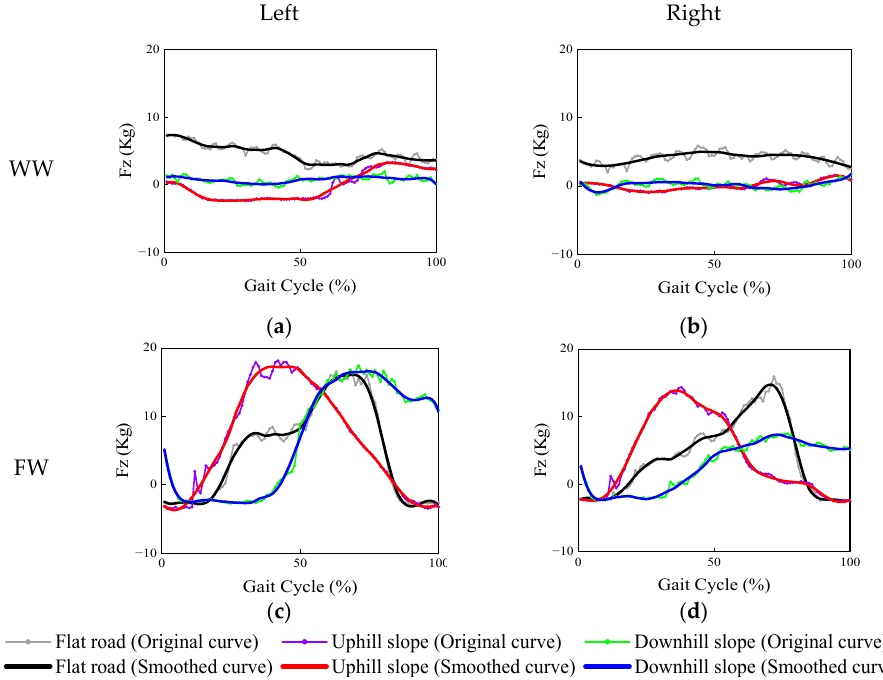
Figure 6. Supporting force on both sides of the walking aids, including: ( a ) force on the left side of the WW; ( b ) force on the right side of the WW; ( c ) force on the left side of the FW; and ( d ) force on the right side of the FW.